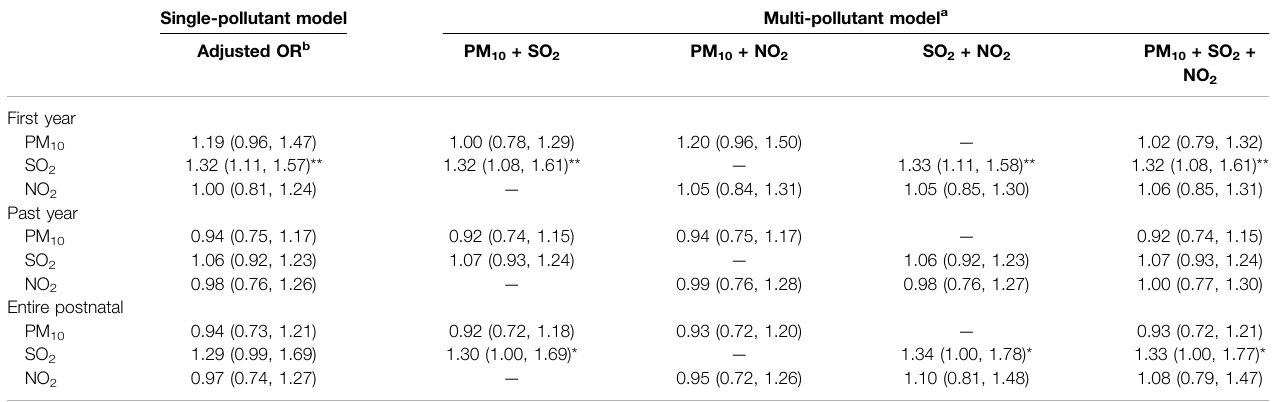
TABLE 4 | Odds ratio of laryngitis due to exposure to outdoor air pollution within different time windows among children in the age range of 3 – 6 years ( n = 2,328).